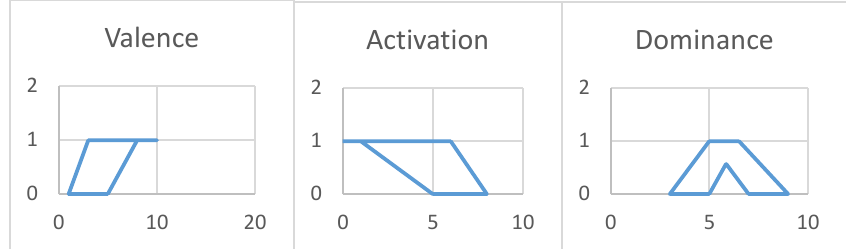
Fig. 8. The FOU of Ara (Mad) for dimensions valence, activation and dominance.